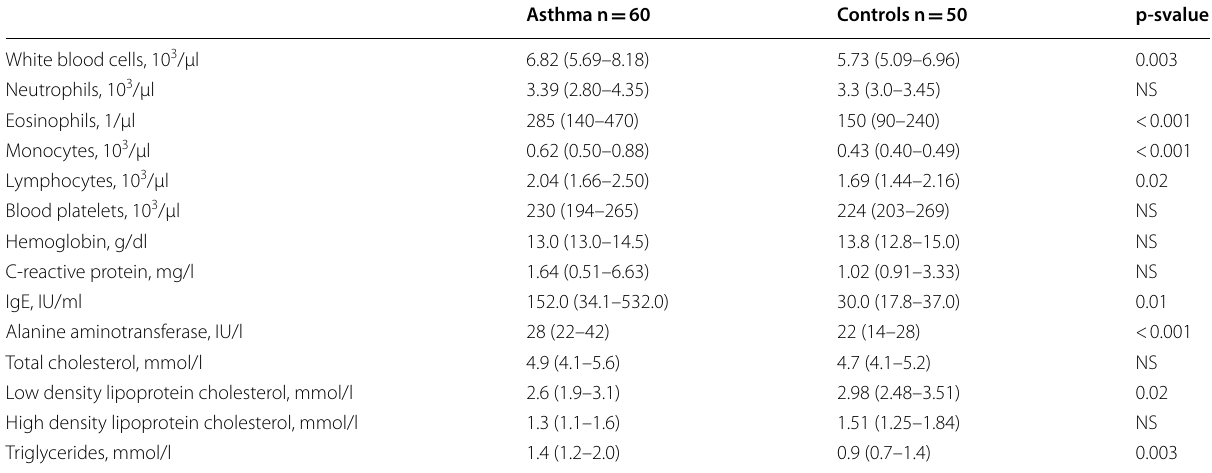
Variables are presented as median and interquartile range